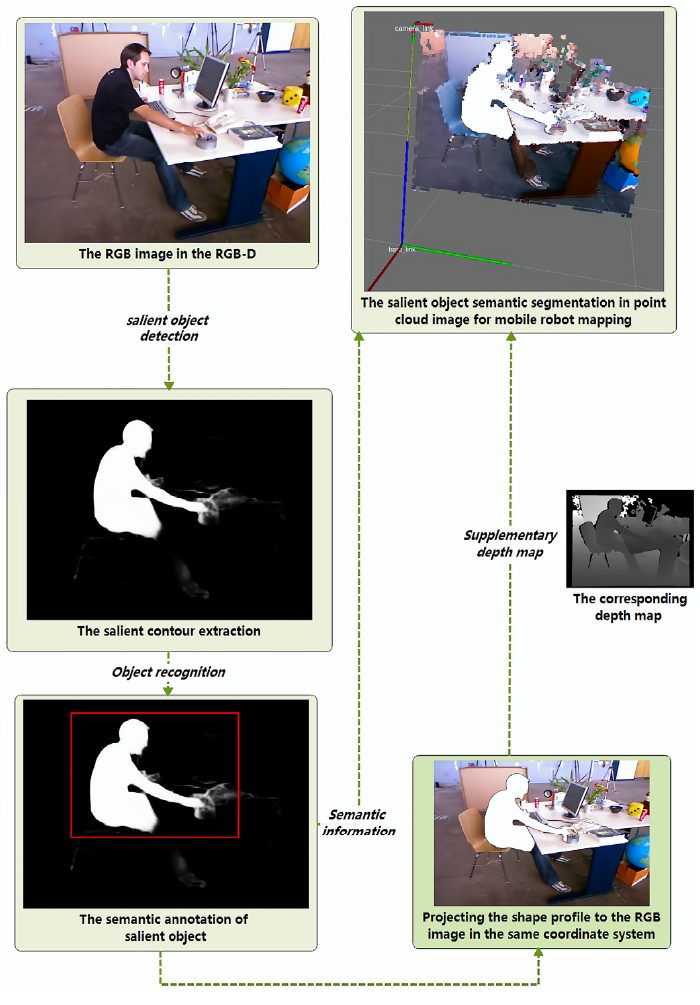
Figure 1. The flow chart with illustrations. The picture used is from the TUM dataset.